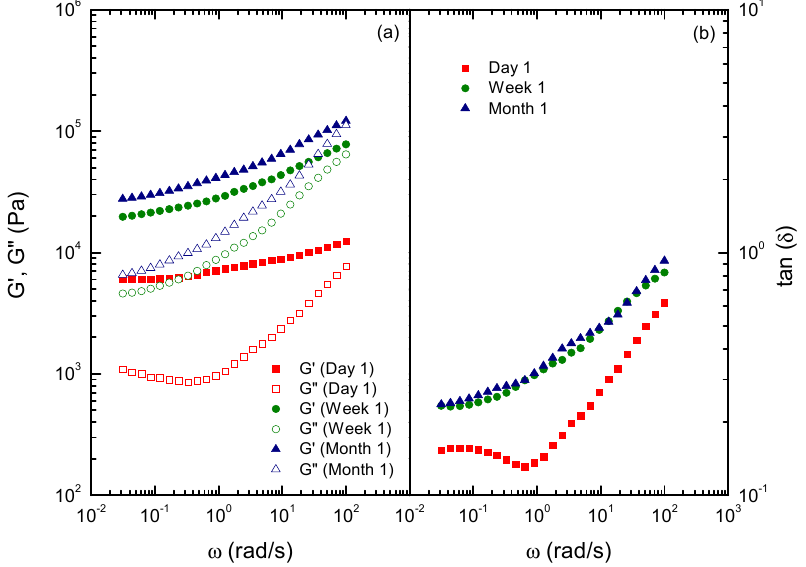
Figure 9. Frequency dependence of the ( a ) storage [G'] and loss [G''] moduli, and the ( b ) loss tangent for the NCO–functionalized chitin gel-like dispersion in castor oil (CTIN-1-30), as a function of the ageing time (G': full symbols, G'': open